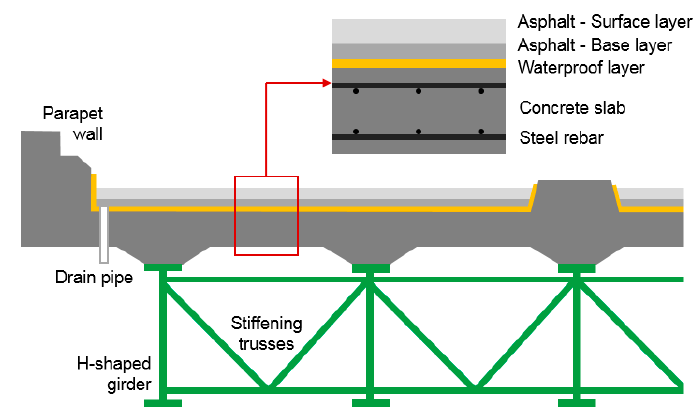
Figure 1. Typical cross-section of the bridge structure.